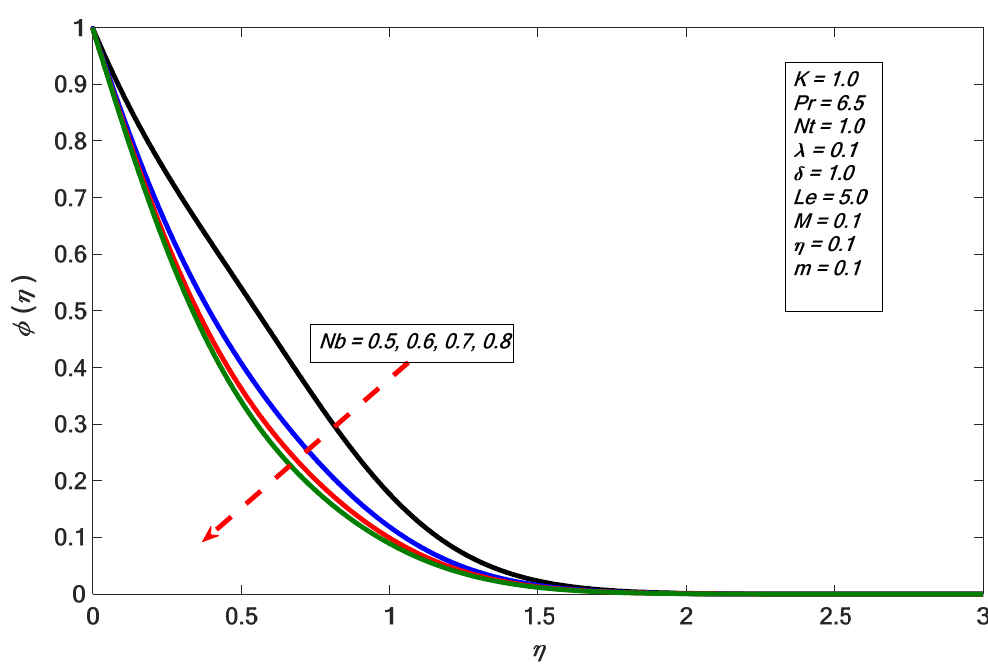
Figure 8. φ ( η ) for various values of Nb Figure 8. 𝜙(cid:4666)𝜂(cid:4667) for various values of 𝑁𝑏 .